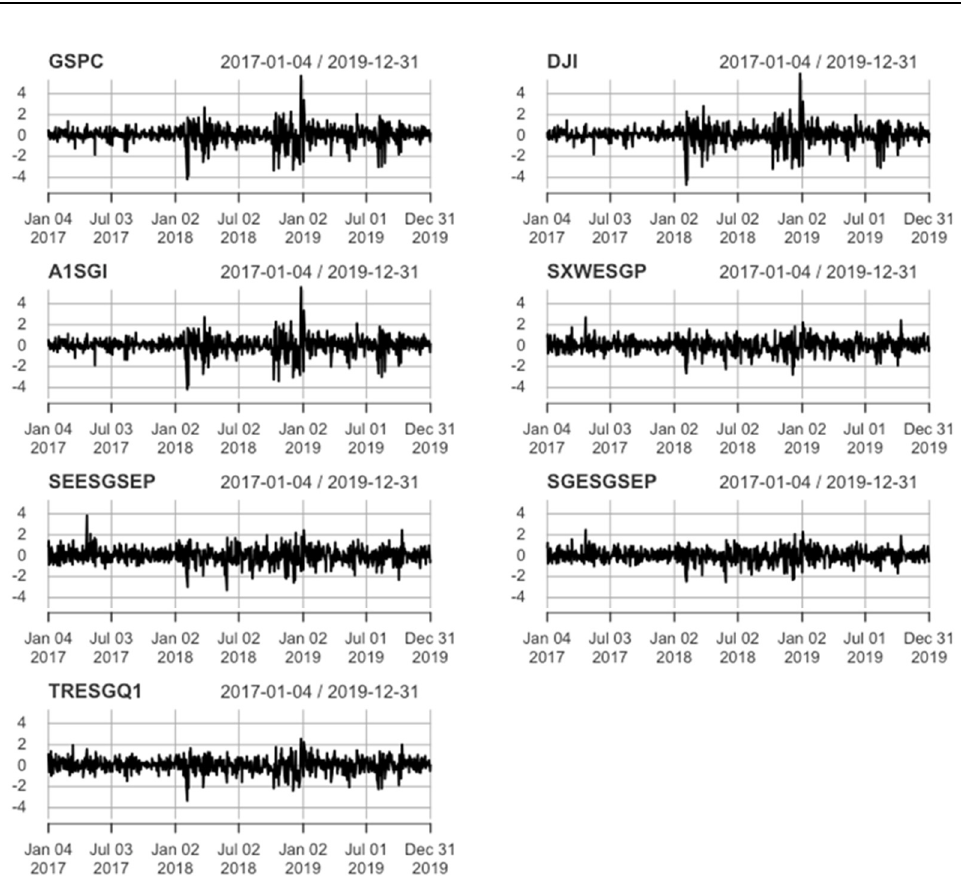
Figure 7. The rates of return, 4 January 2017–31 December 2019. The highest values of Kendall’s τ (see Figure 8) are between indices of the same type (S&P 500 and DJI, and SEESGSEP and SGESGSEP). High dependence is observed between S&P 500 and A1SGI and between DJI and A1SGI, low dependence between S&P 500 and SEESGSEP, and between DJI and SEESGSEP. For example, for the GSPC–SEESGSEP relationship—the observed copula has the lowest dependency—depends by 16.50% on the upper tail and 16.50% on the lower tail (the same dependency). The pair GSPC–A1SGI has a dependency of 88.22% on the lower tail, and of 85.32% on the upper tail. It means